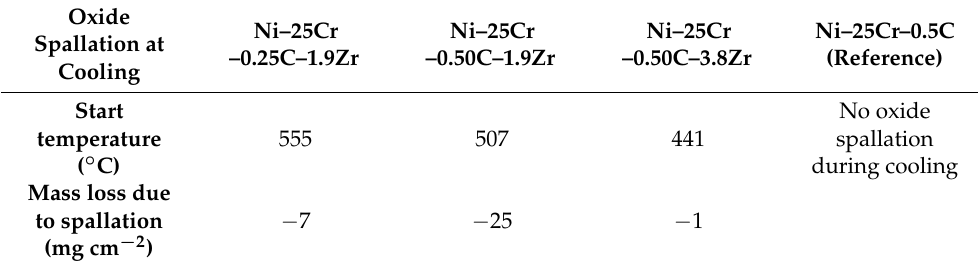
Figure 4. Mass variation recorded during the whole thermal cycle for the three Zr–containing alloys in comparison with the reference ternary alloy; “NZ1”, “NZ2”, and “NZ3” are the Ni–25Cr–0.25C–1.9Zr, Ni–25Cr–0.50C–1.9Zr, and Ni–25Cr–0.50C–3.8Zr alloys, respectively. Table 7. The values of two parameters characterizing the scale spallation during the post-isothermal stage cooling for the three Zr–containing alloys; comparison with the reference ternary alloy.